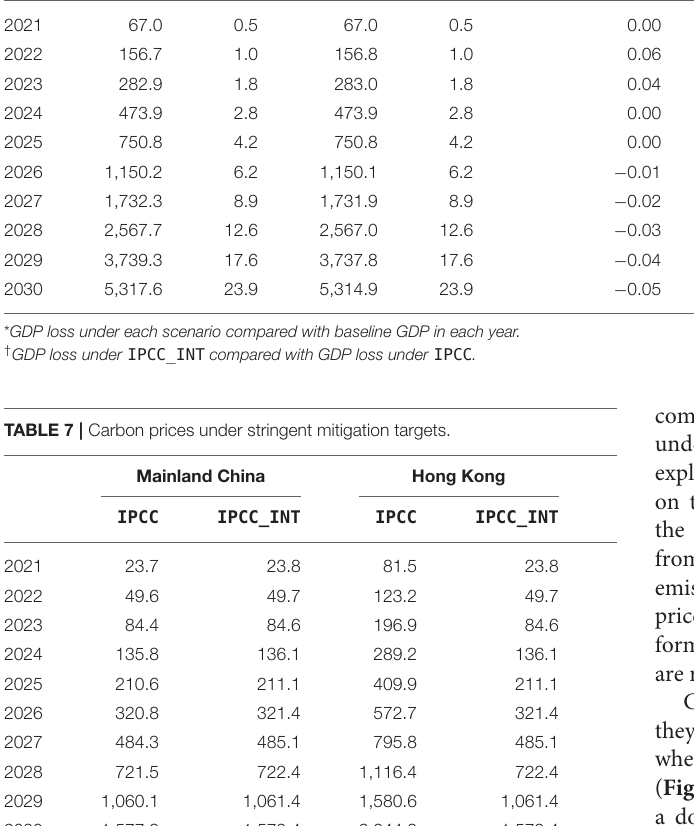
TABLE 6 | GDP loss under stringent mitigation targets (vs. BAU levels). Mainland China Hong Kong IPCC IPCC_INT